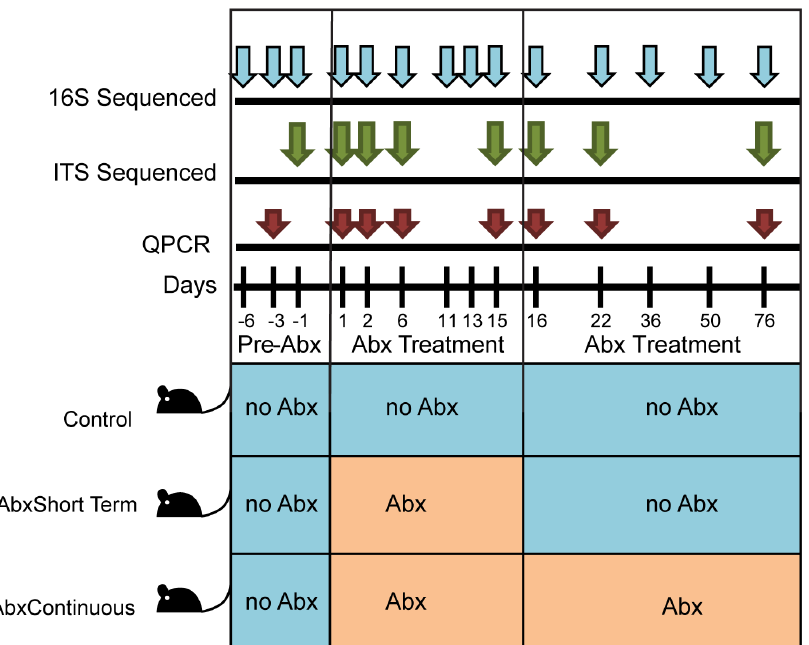
Figure 1. Diagram of the experiment. The time line for the 76 days of sample collection is shown along the top, and the periods of antibiotic treatment are shown at the bottom. Antibiotic treatment was initiated at time